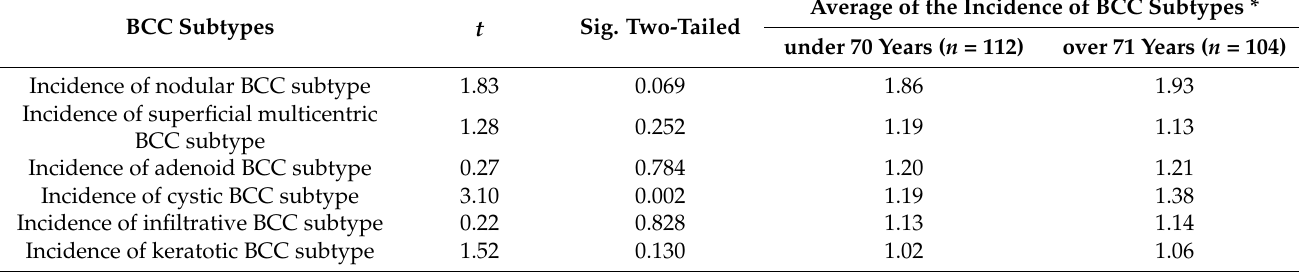
Table 5. Comparison of the incidence of the six histopathological BCC subtypes according to the age of the subjects.